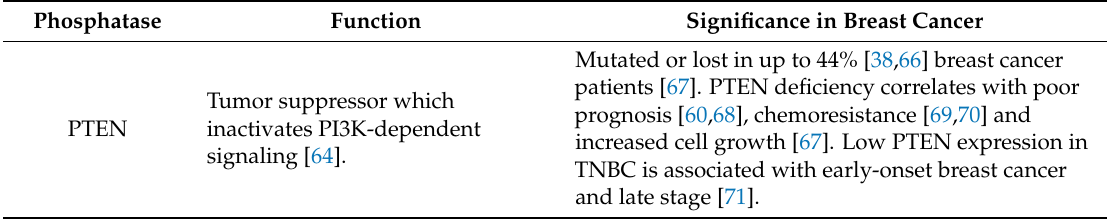
Table 5. Phosphatase and Tensin Homologue (PTEN) alterations and significance in breast cancer. Phosphatase Function Significance in Breast Cancer